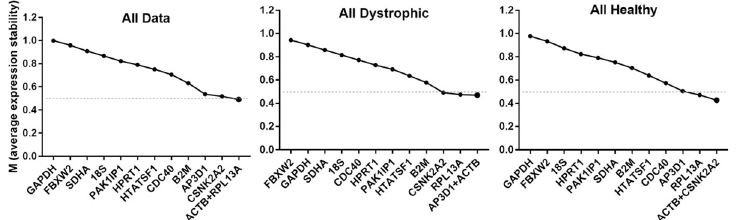
Fig 2. geNorm analysis. Representative outputs of the geNorm algorithm. geNorm ranking by average expression stability M (left to right: least stable to most stable) for the entire dataset, or dystrophic or healthy samples alone (as indicated). Dashed line: M = 0.5 (threshold of stability for strong